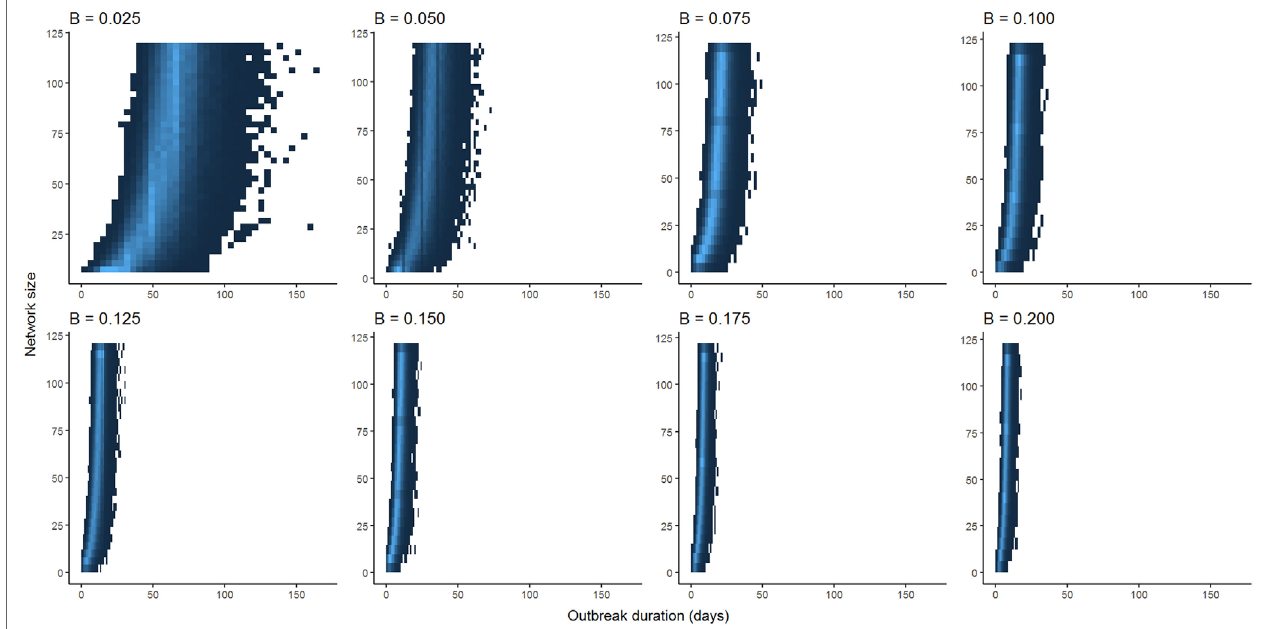
FIGURe 2 | Comparison between distributions of outbreak durations for susceptible-infected simulations with varying values for β . Lower values for β have larger ranges of outbreak durations, but the shapes of curves are qualitatively similar when scaled to the maximum outbreak duration for a given value of β